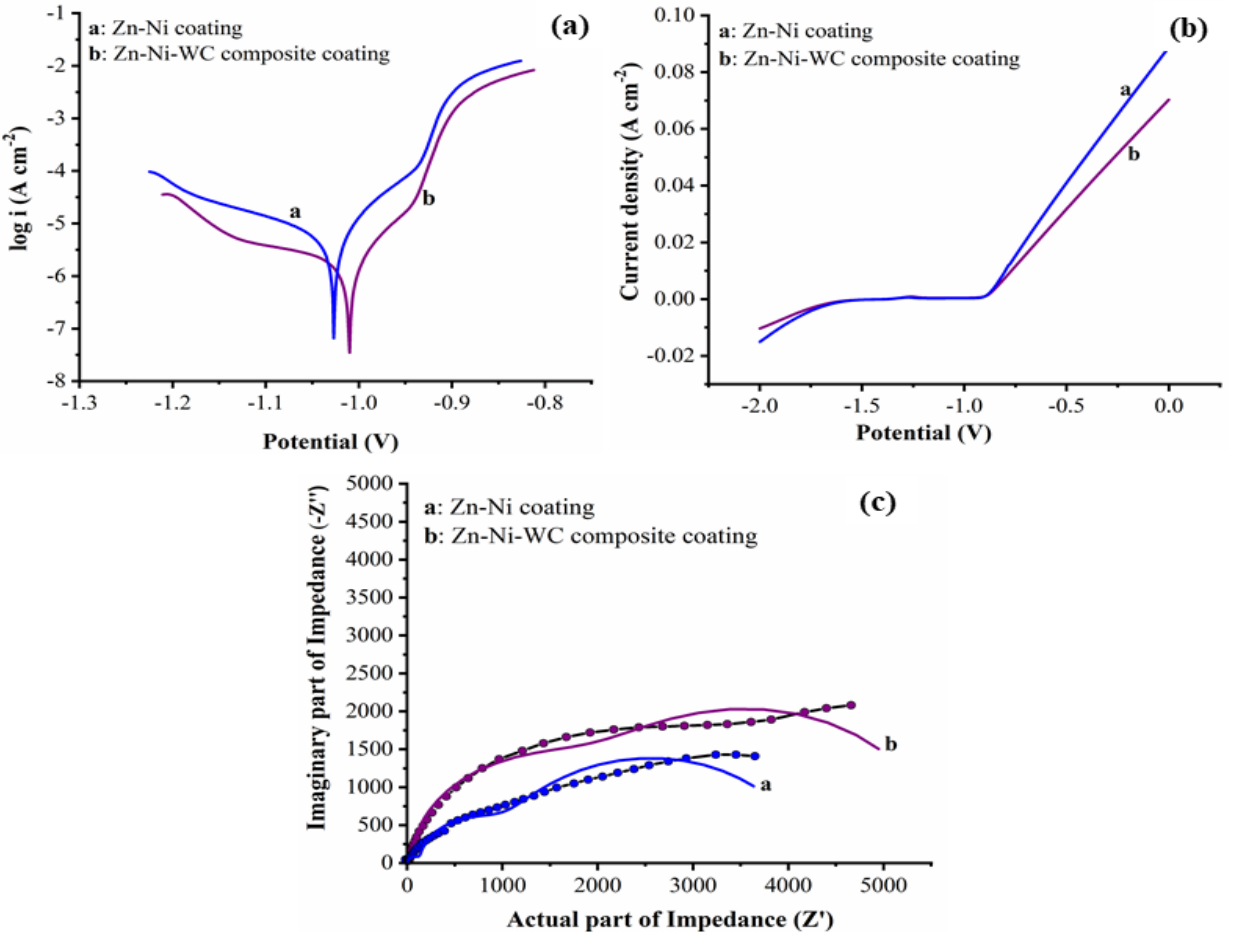
Figure 10. Zn–Ni alloy and Zn–Ni–WC composites showing ( a ) potentiodynamic curves of the coatings ( b ) anodic PC of coatings ( c ) impedance spectra.